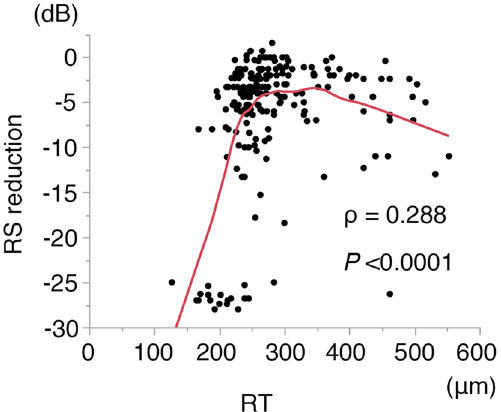
Figure 3. Correlations between retinal thickness and reduction in retinal sensitivity. Scatter plots of RT versus reduction in RS. Spearman’s correlation coefficient (ρ) was calculated. Red line shows locally weighted scatterplot smoothing curve. RT retinal thickness, RS retinal